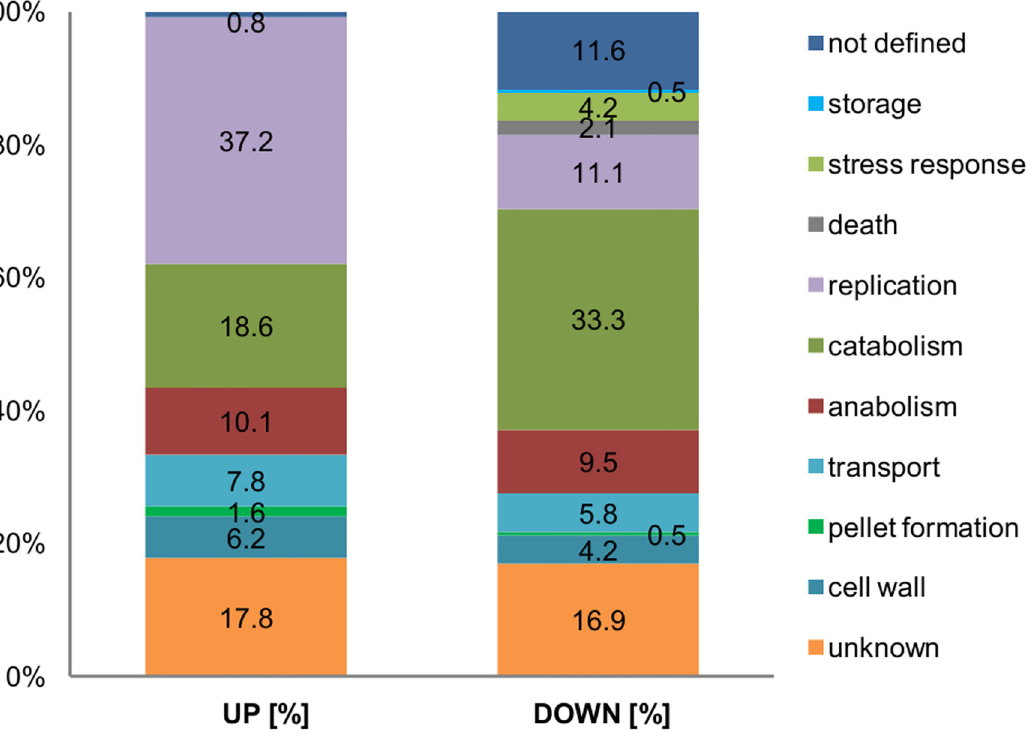
Fig 3. Overview of GO data of mutant strain LF580-M26 in comparison to wild type strain LF580. 3526 proteins were quantified using iTRAQ labelling. 318 (9%) showed a significant regulation in the mutant strain. 129 (3.7%) were upregulated and 189 (5.3%) were downregulated. The bar chart shows the percentage of up- and downregulated proteins sorted to the different categories on the basis of GO annotation.